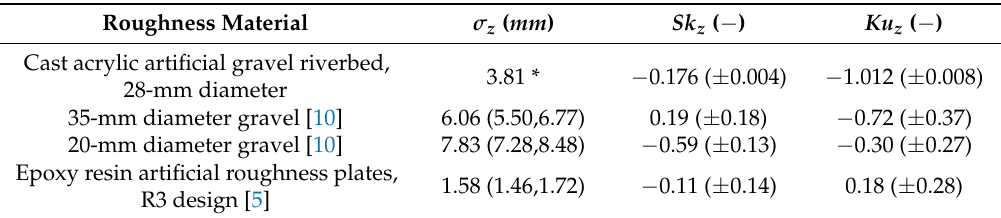
Table 2. Bulk statistics of various artificial and natural gravel riverbeds, table adapted from Stewart et al. [5] (p. 7) to include multiple studies.